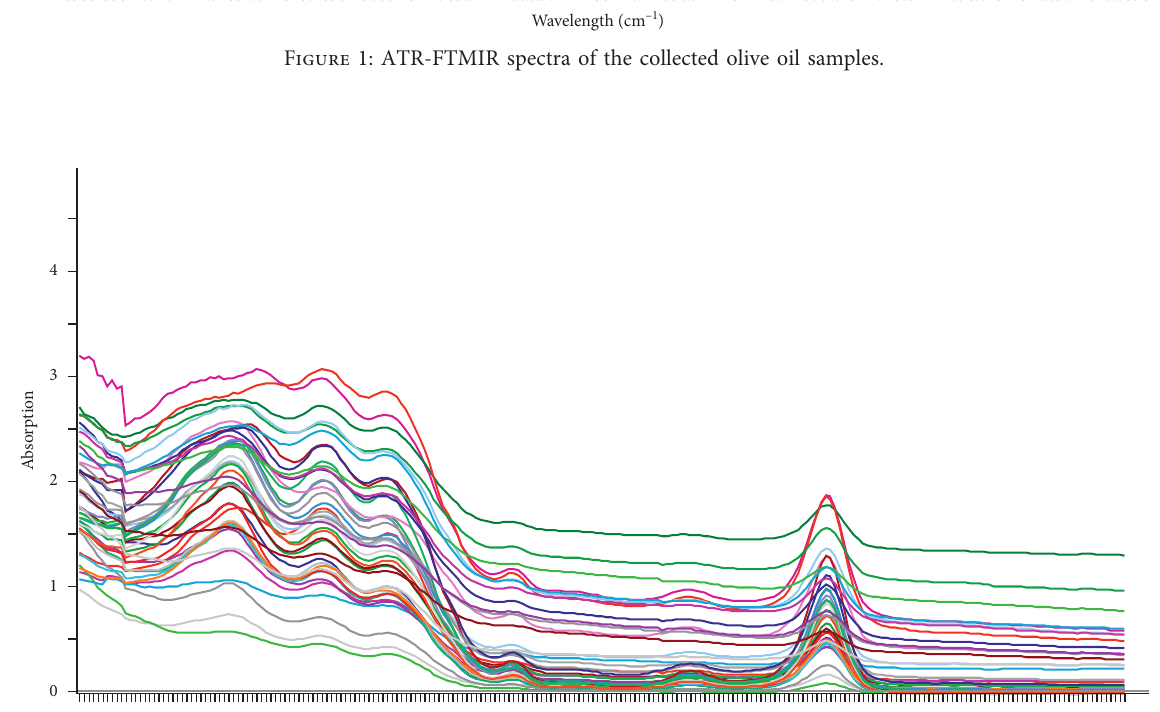
Figure 2: Olive oil UV-Visible spectra at wavelengths between 350 and 800nm.